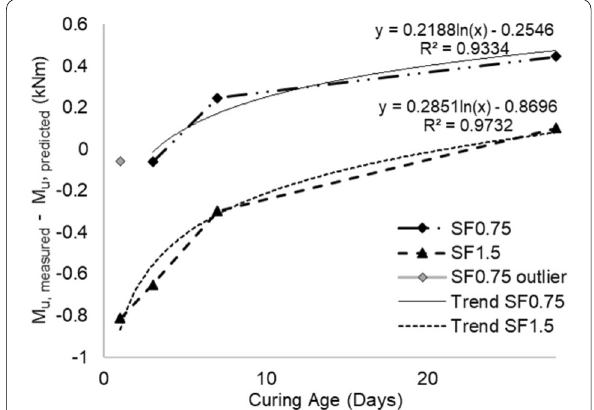
Fig. 10 The difference between the predicted and measured ultimate moment capacity vs. curing